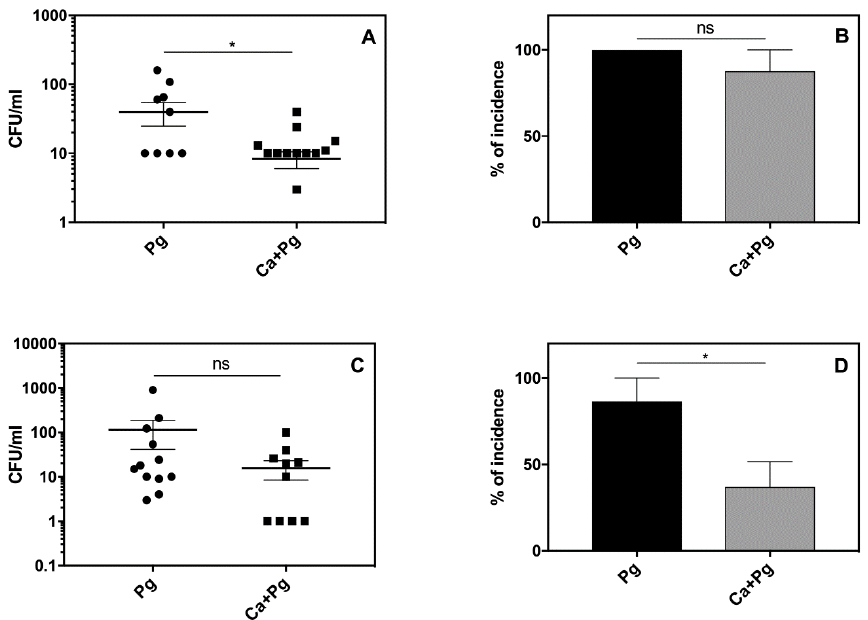
Figure 5. Infiltration of mouse organs by P. gingivalis at 96 h post-infection: ( A , B ) kidney; ( C , D ) spleen. After 4 days of the microbial challenge, the infection of isolated organs was analyzed by counting microbial colonies grown on appropriate agar plates. Two independent experiments were performed ( n = 8 mice). Data for each tissue are expressed as a mean ± SEM. Asterisks denote statistical significance ( p > 0.1234 ns, * p ≤ 0.0332).